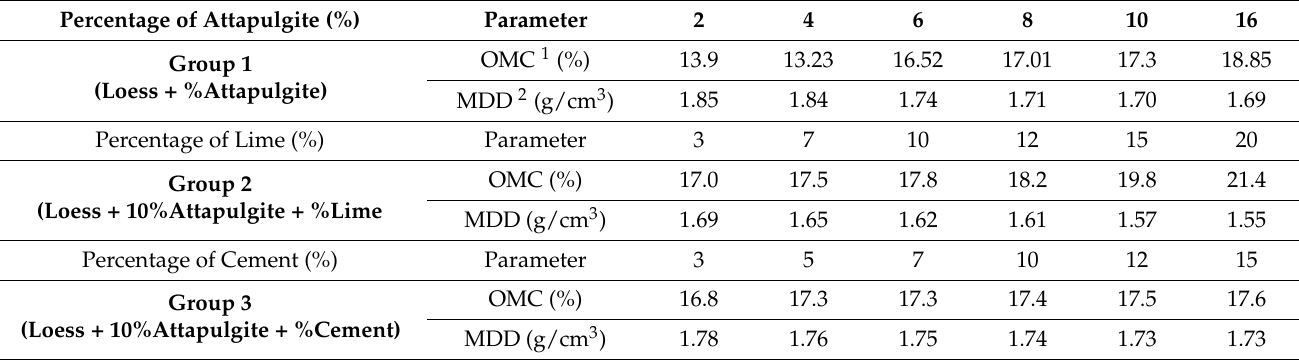
Table 5. Optimum moisture content (OMC) and maximum dry density (MDD) results for the various percentage of materials (attapulgite, lime, and